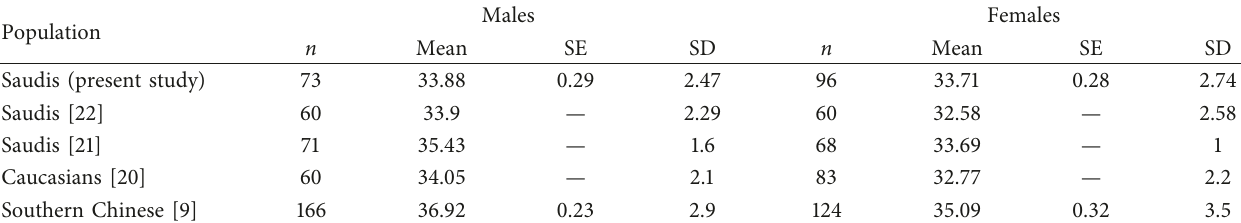
Table 6: Comparison of intercanine (upper canine cusp to cusp) widths between Saudis (different studies), Caucasians, and Southern Chinese. Population